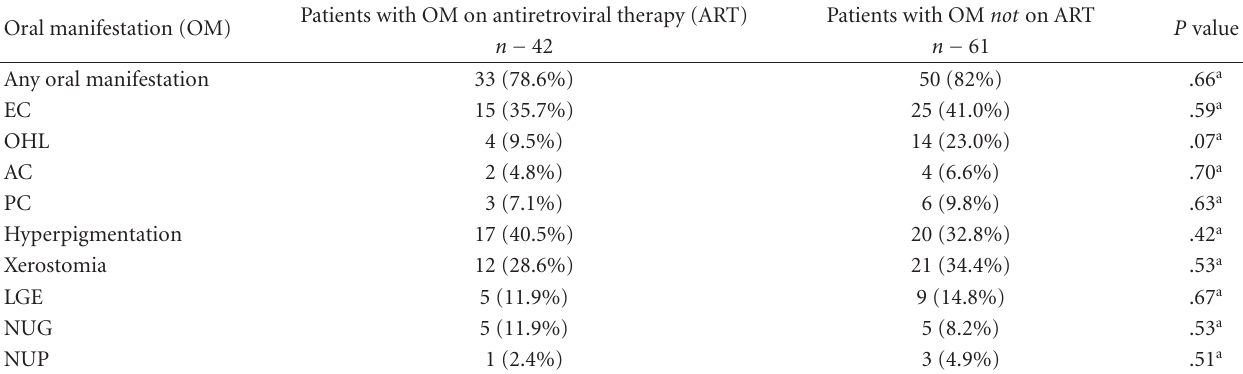
Table 7: Comparison of oral manifestations with respect to antiretroviral